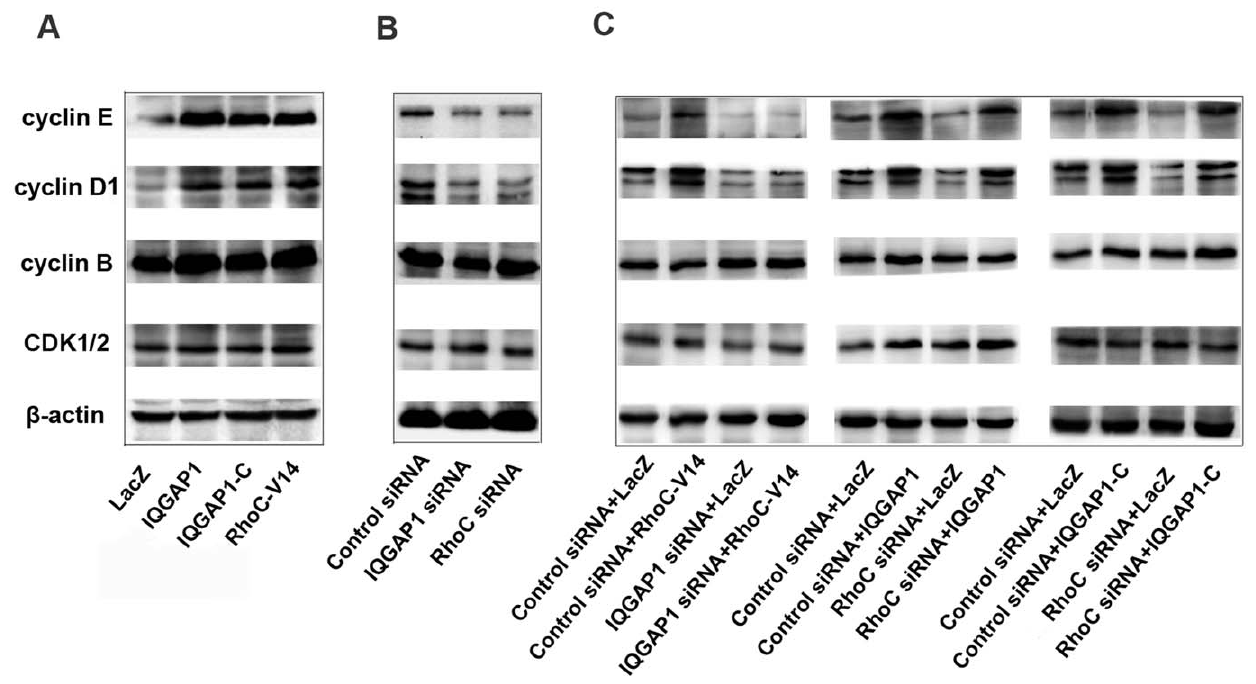
Figure 4. The effects of RhoC and IQGAP1 on expression of cell cycle-related proteins. ( A ) BGC-823 cells were infected with Ad-IQGAP1, Ad-IQGAP1-C or Ad-RhoC-V14 for 48 h, and Western blot was used to analyze the expressions of cyclin E, cyclin D1 cyclin B and CDK. ( B ) BGC-823 cells were transfected with IQGAP1 siRNA or RhoC siRNA for 72 h, and the expressions of cyclin E, cyclin D1, cyclin B and CDK were analyzed by Western blotting. ( C ) The protein expressions of cyclin E, cyclin D1, cyclin B and CDK in BGC-823 cells which were transiently transfected with IQGAP1 siRNA or RhoC siRNA for 24 h and afterwards infected with Ad-RhoC-V14, Ad-IQGAP1-C or Ad-IQGAP1 for additional 48 h (Results of Western blotting).